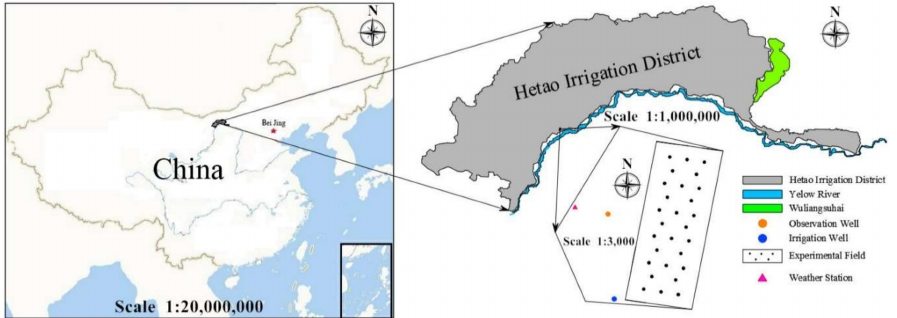
Figure 1. Schematic of the experimental field